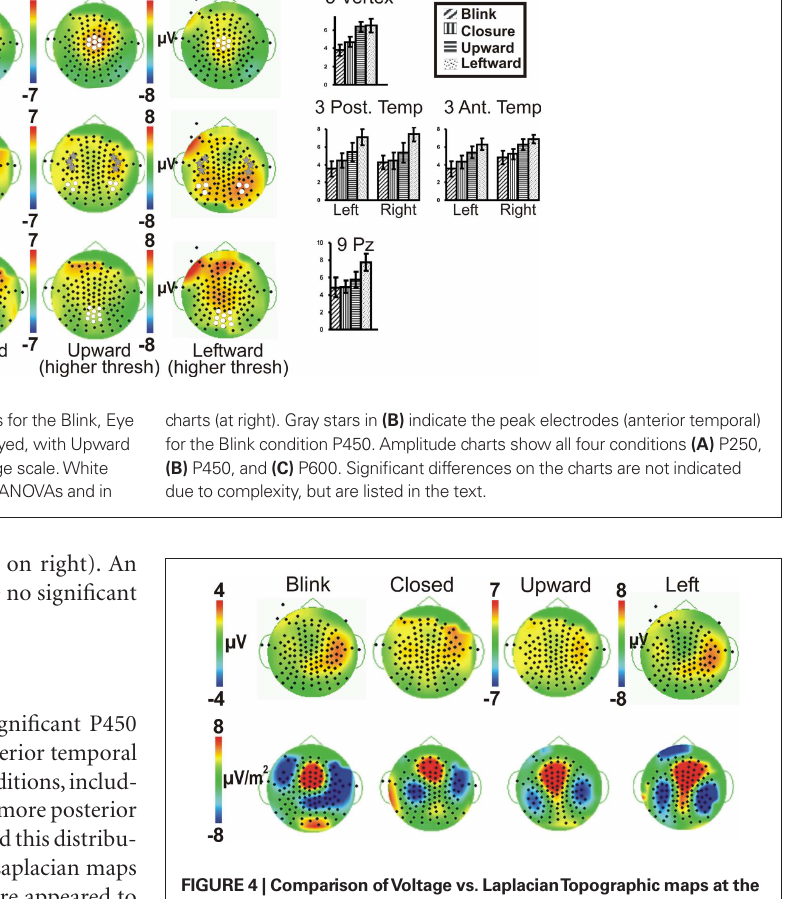
FiguRE 4 | Comparison of Voltage vs. Laplacian Topographic maps at the peak latency of P450 . Voltage maps (top row) and Laplacian maps (bottom row) are shown for all four eye movement conditions, with threshold matched across conditions. Positive amplitudes/sources are warm colors; Negative amplitudes/sinks are cool colors as shown in the colored scale bar.